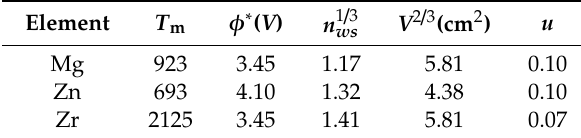
Table 1. The parameters of Mg, Y, Zn, and Zr, data from [12].